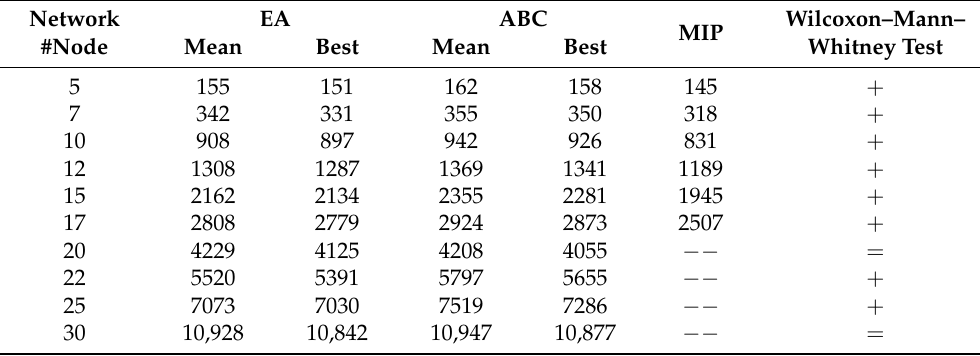
Table 3. Comparison of the average and the best value of the objective function evaluation for each test case together with the outcomes of the paired Wilcoxon test, for ELP model. Symbols + , − and = indicate whether the EA algorithm was better ( + ), worse ( − ) or equal ( = ) to the ABC algorithm. Network